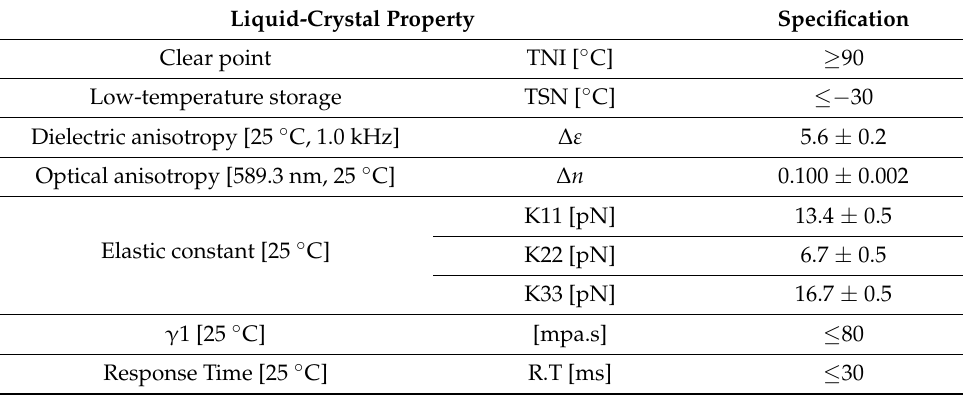
Table 2. Specifications of the physical